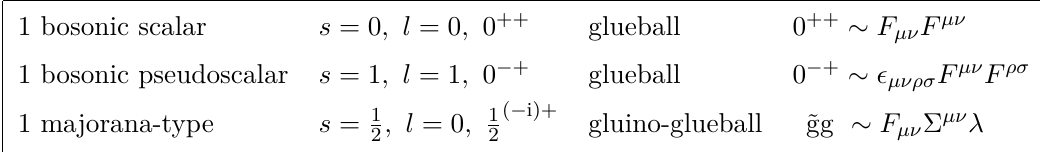
Table 2 . Farrar-Gabadadze-Schwetz supermultiplet. a global U (1) symmetry 2 λ 7→ e i αγ 5 / 2 λ . The axial anomaly reduces this U (1) A